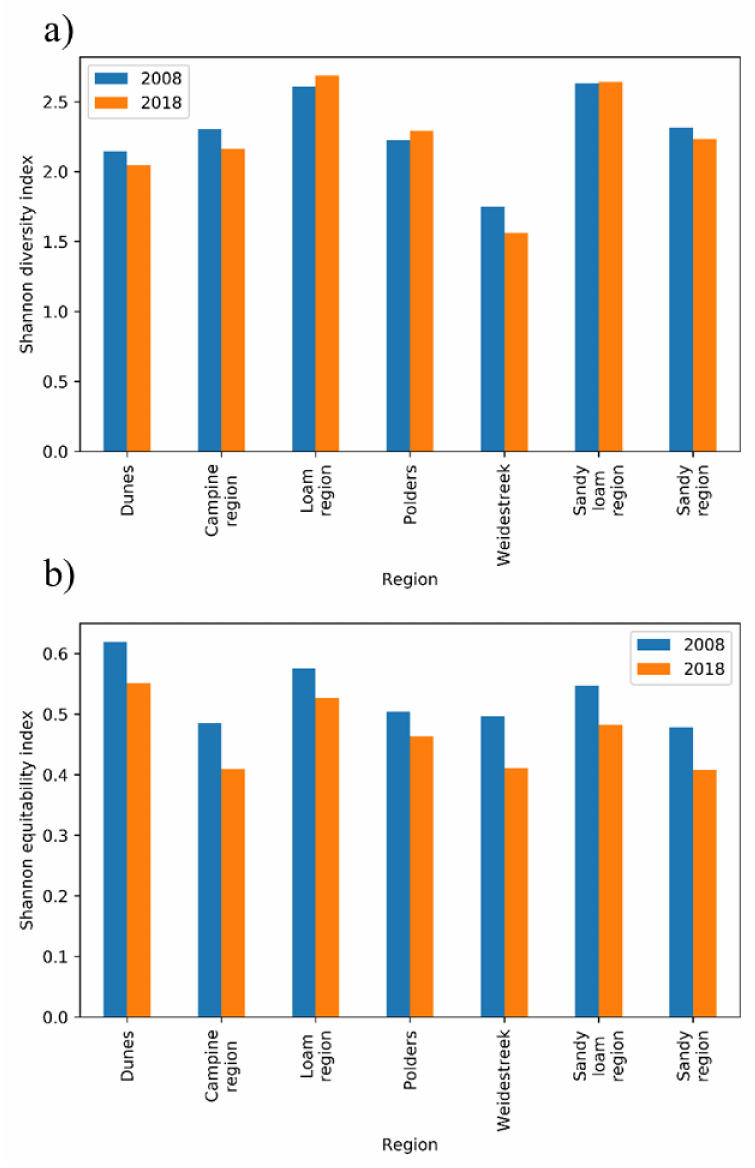
Figure 4. Comparison of crop diversity between the different agricultural regions in Flanders between 2008 and 2018, as measured by ( a ) the crop Shannon diversity index (CDSD) and ( b ) the crop diversity Shannon equitability index (CDEI). (Data source: